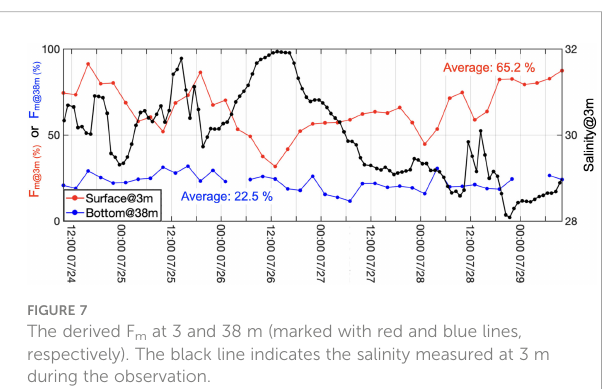
FIGURE 9 Calculated shear velocities induced by currents and current-wave couplings (u *c and u *cw , marked with yellow dots). The dashed and solid red lines indicate the critical shear velocities of the 63 µm grain size with the measured particle density (1.53 g cm -3 ) and the assumed detrital density (2.65 g cm -3 ), respectively. The dashed blue and solid lines indicate the critical shear velocities of the 153 µm grain size with the measured particle density and the assumed detrital density,